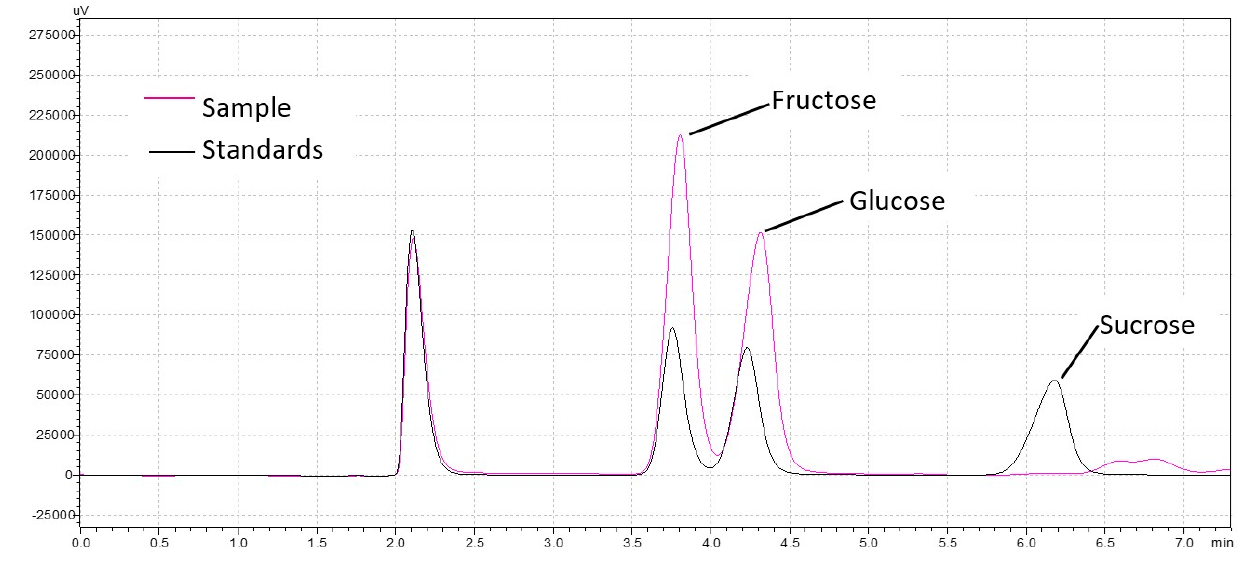
Figure 1. HPLC chromatogram of sugar standards and spring flower honey sample. Table 1. HPLC analysis of sugars in honey